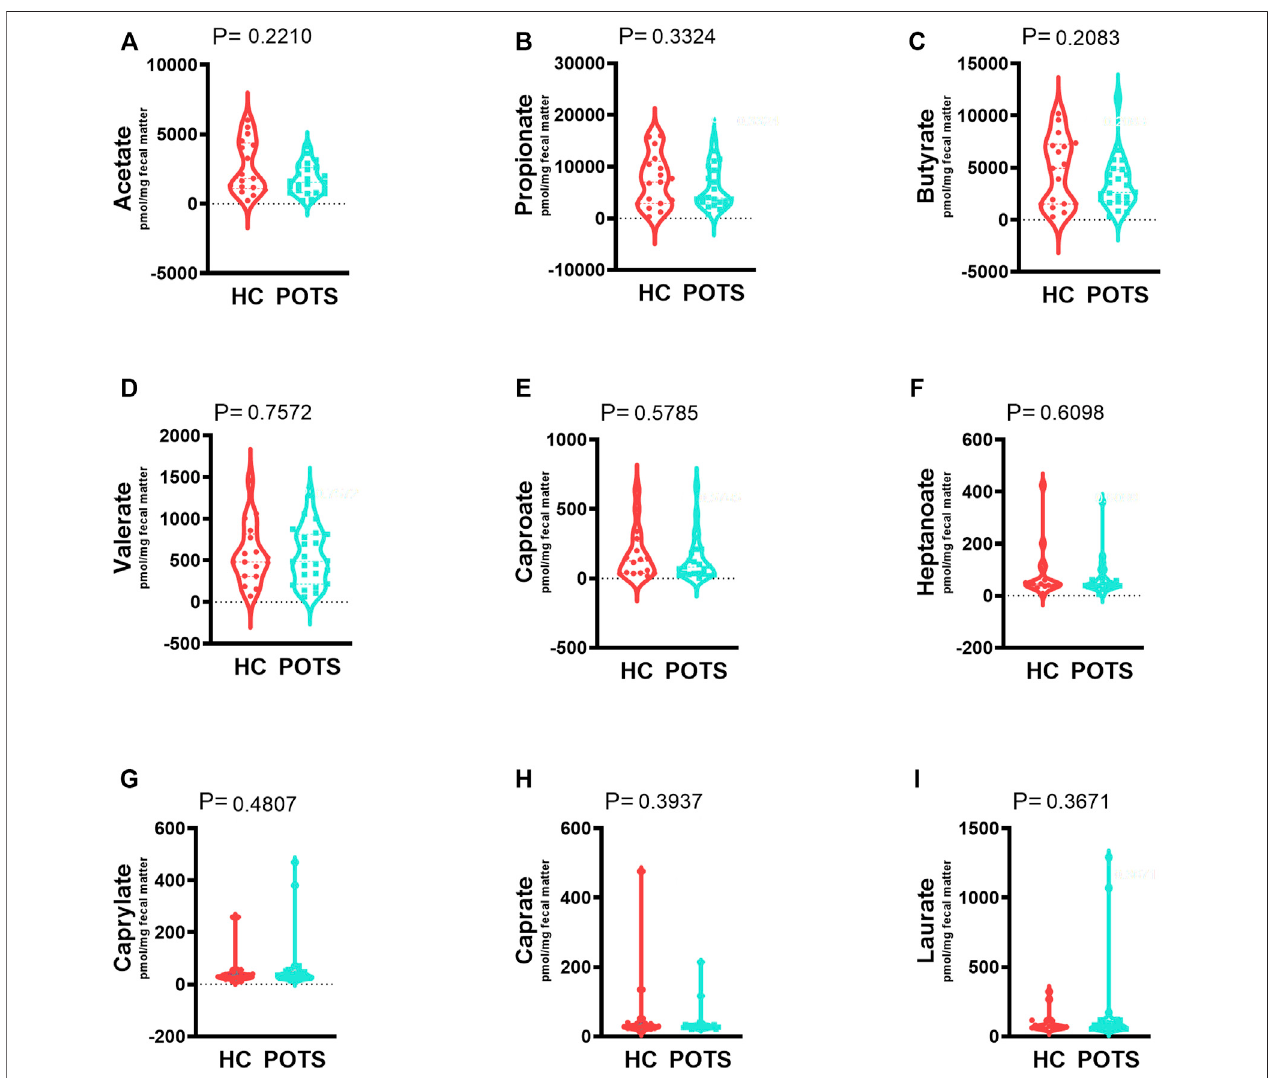
FIGURE 7 | The relationship between POTS and short-chain fatty acids (SCFAs) in the gut microbiome. The fecal samples were collected from control and POTS individualsandthelevelsofSCFAsweremeasured withLC-HRMS atVanderbiltUniversity.Wemeasured fecallevelsofthe (A) acetate; (B) propionate; (C) butyrate; (D) valerate; (E) caproate; (F) caprylate; (G) caprate; (H) laurate and (I) heptanoate. Our results indicate that POTS patients and healthy controls had similar levels of all measuredSCFAs( Figures7A – H ).Dataarepresentedasmean±SEM.StatisticalanalyseswereperformedusingStudent ’ s t -test. N =25forPOTSand N =23for healthy control participants and p < 0.05 was set for statistical signi fi